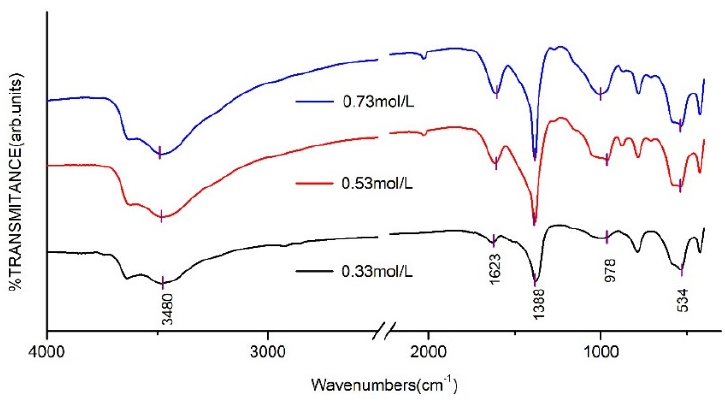
Figure 11. FT-IR spectrum of CaAl–SiO 3 –LDHs prepared at different Ca 2+ molar concentrations.